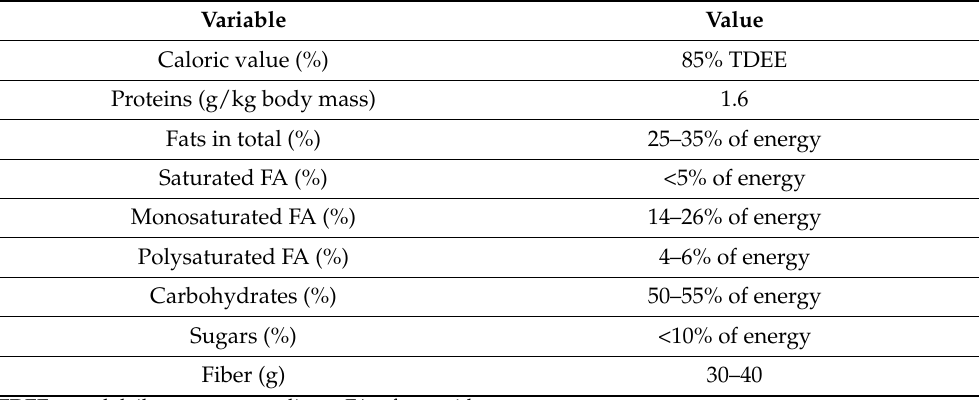
Table 1. General characteristics of the interventional